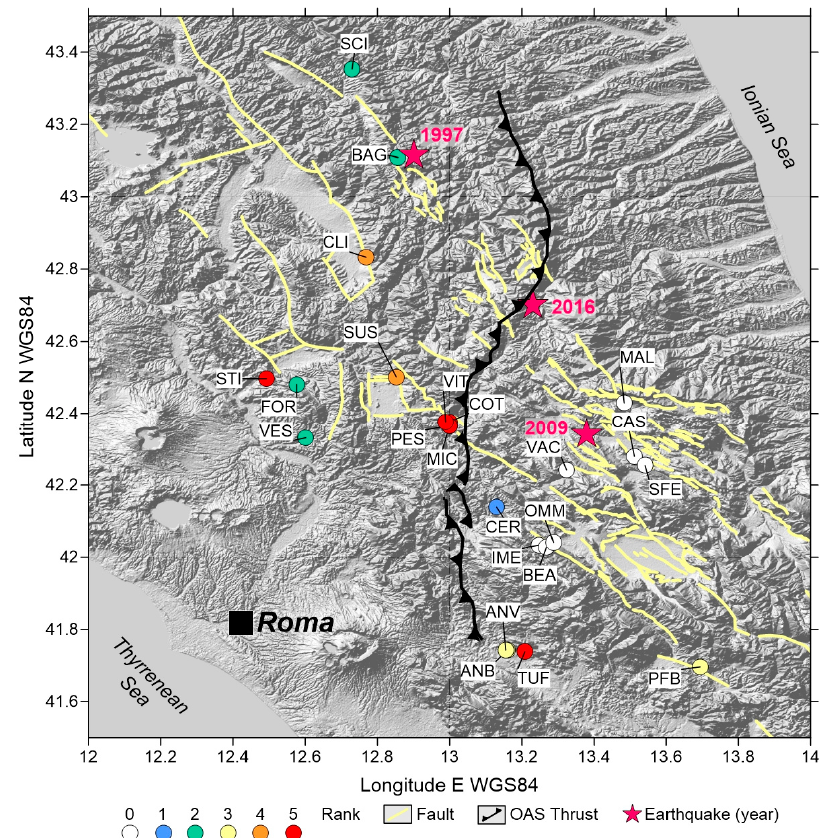
Figure 10. Classification of the sampling sites based on their ranking for neotectonic activity monitoring purposes (see main text for details). Faults able to generate seismicity, the Olevano-Antrodoco-Sibillini (OAS) thrust and the epicenters of the most recent destructive earthquakes are also reported.